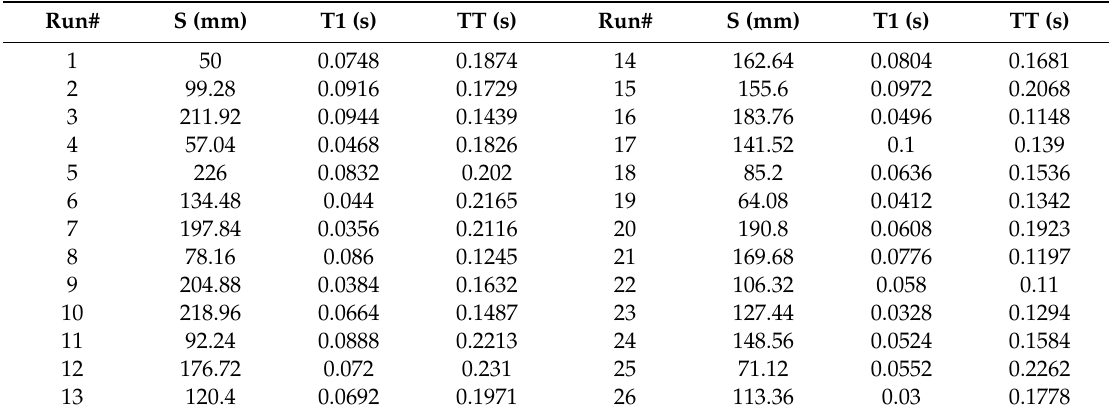
Table 3. Design variables for experiment plan